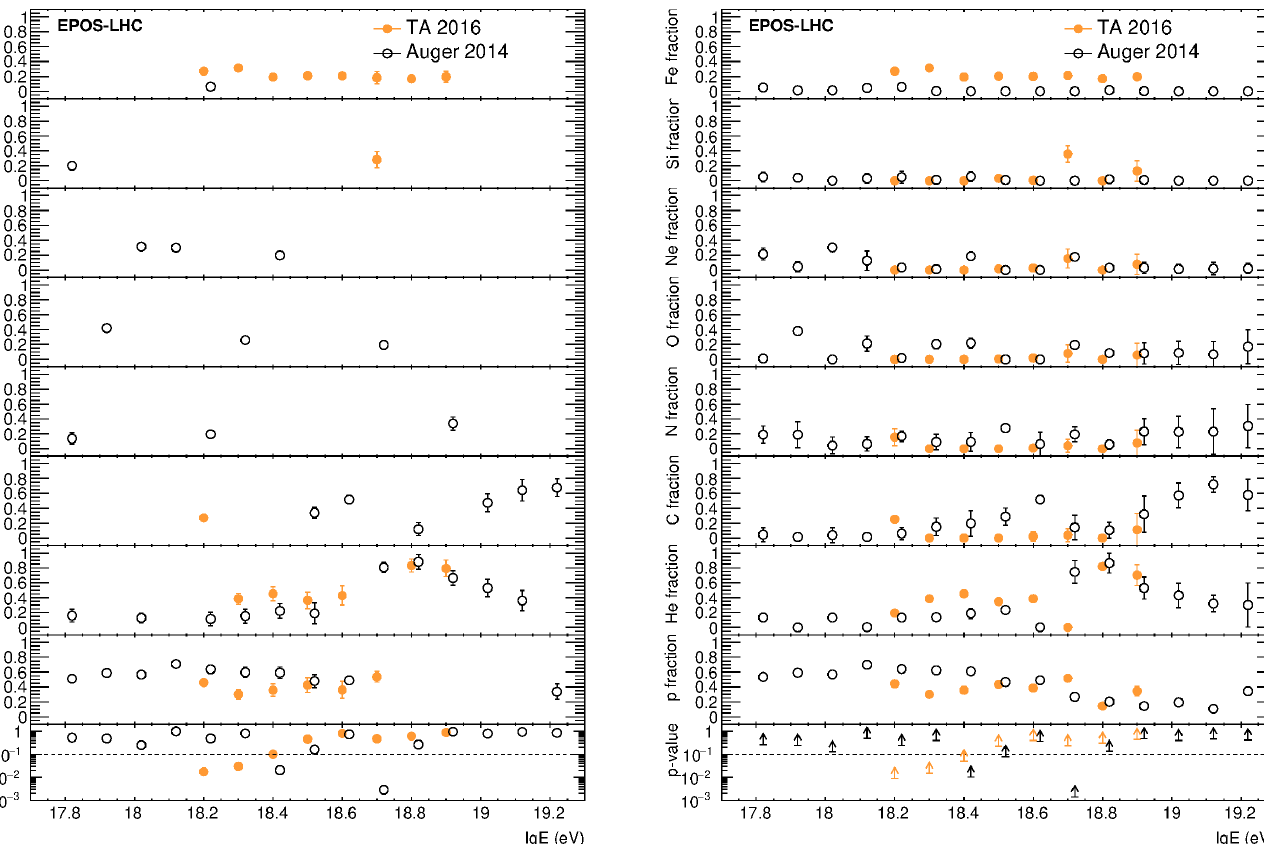
Figure 2. Fitted fractions of individual nuclei in each energy interval obtained with method #1 ( left ) and method #2 ( right ) employing the EPOS-LHC hadronic interaction model. Full orange circles stand for TA (2016) data while the black open circles represent the Auger (2014) data. The p-value parameters are displayed on the bottom panels as one single value per energy interval ( left ) and a range of p-values represented with arrows ( right ) (see